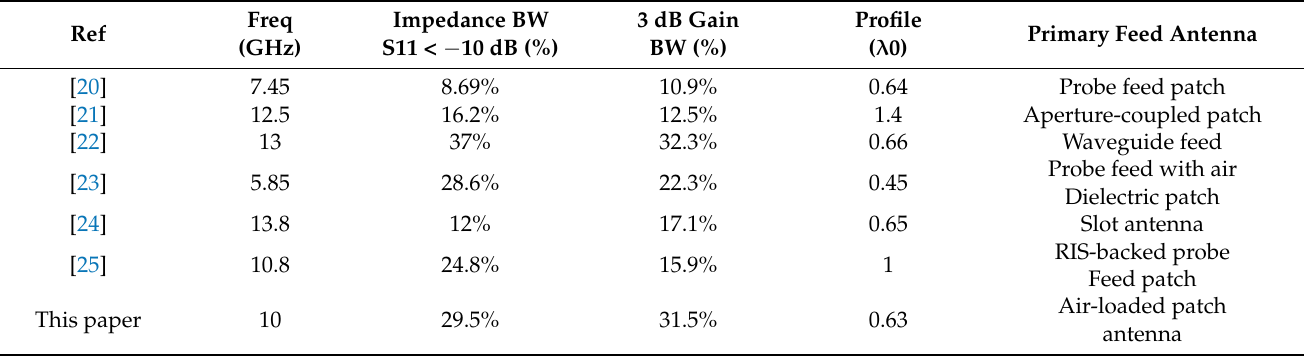
Table 3. Performance comparison of broadband high-gain F-P antennas.